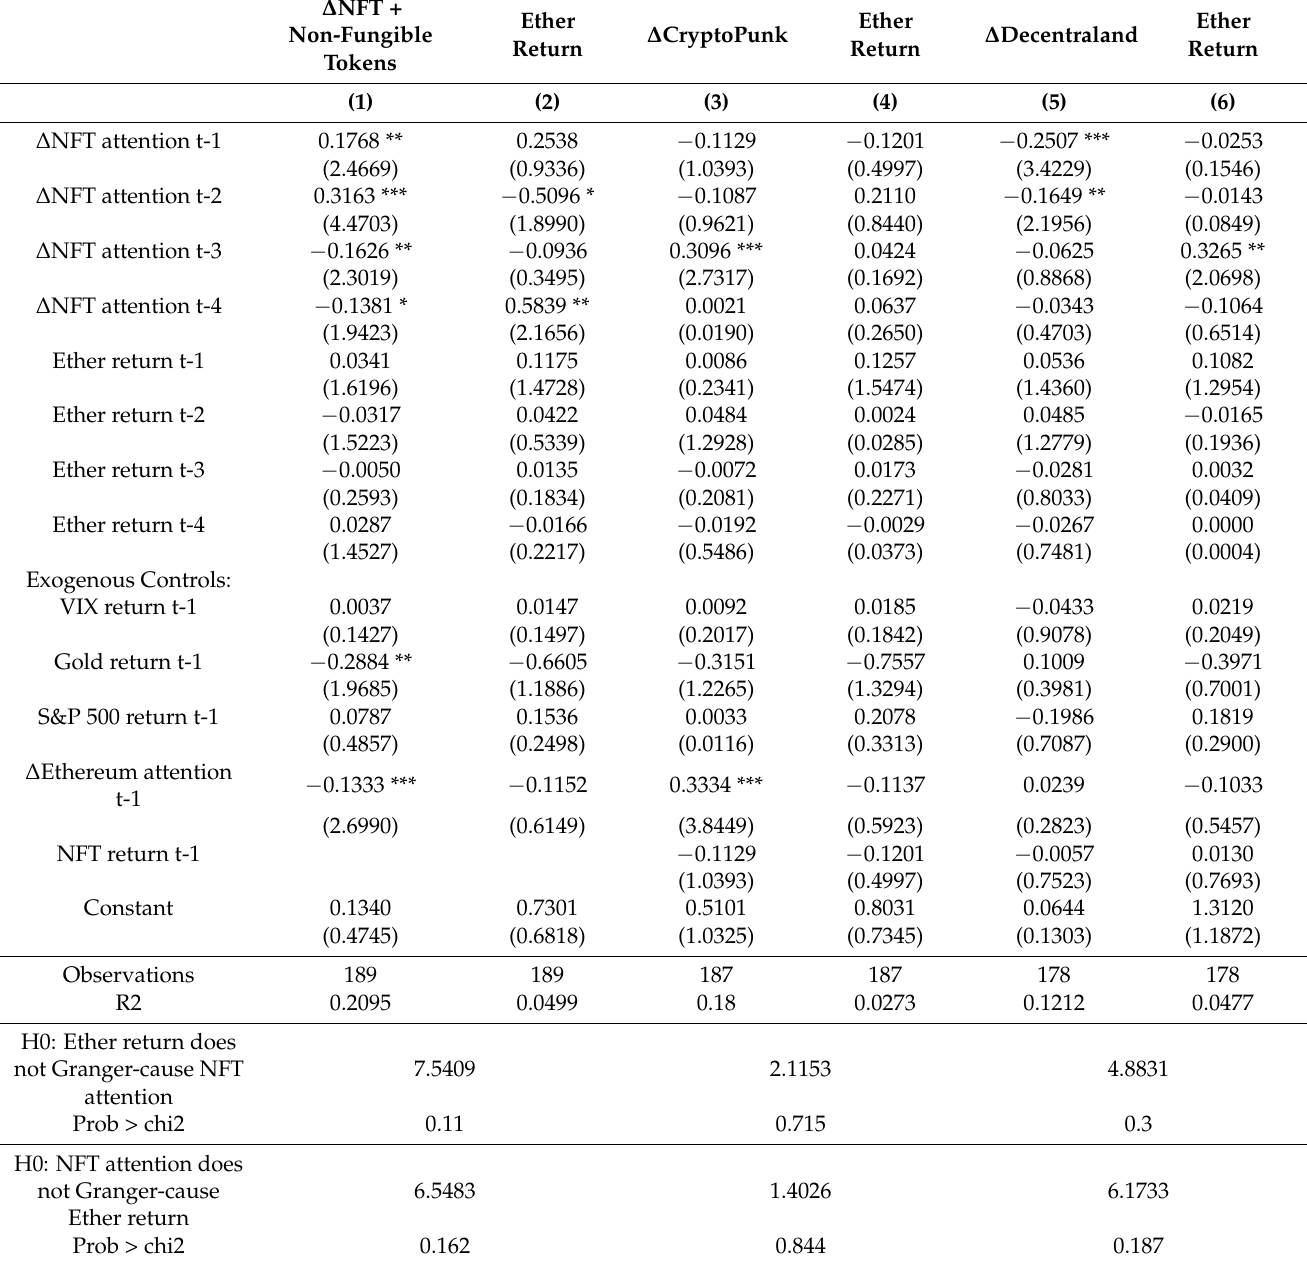
Table 3. Dynamic relationships among NFT attention and Ether